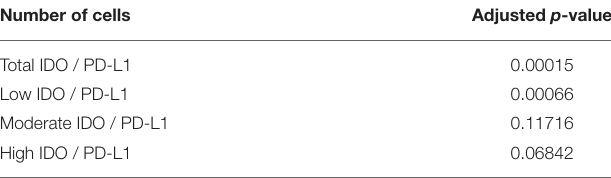
TABLE 2 | Correlation of PD-L1 and